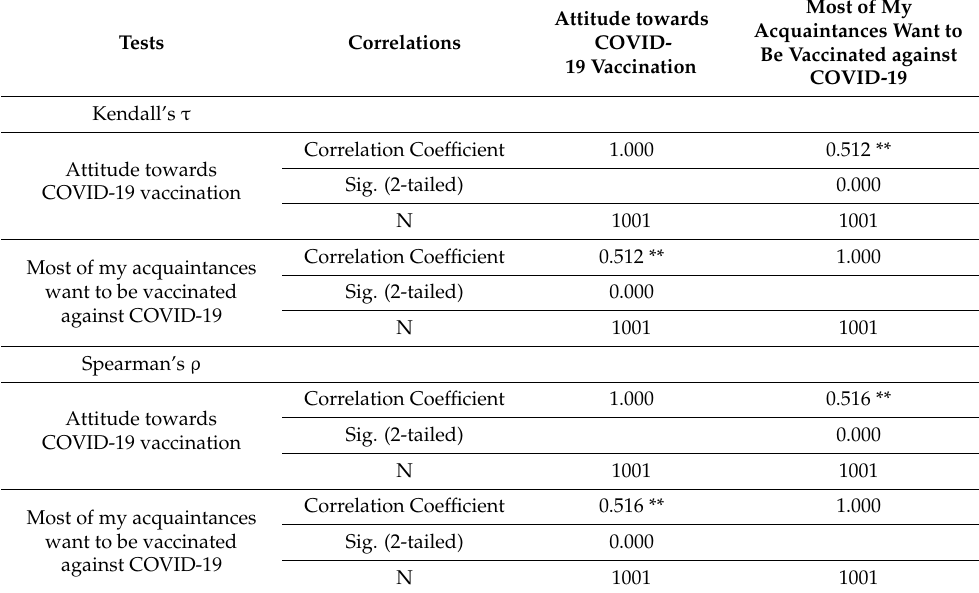
Table 5. Results of Kendall τ and Spearman ρ tests.